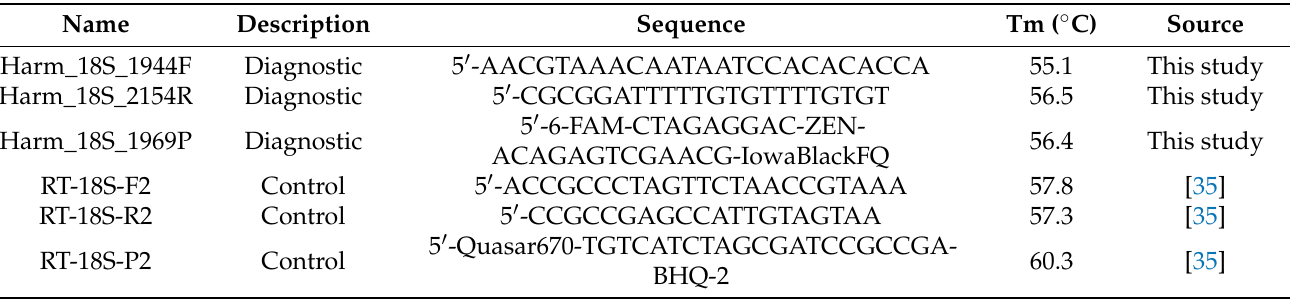
Table 1. Primers and probes used in this